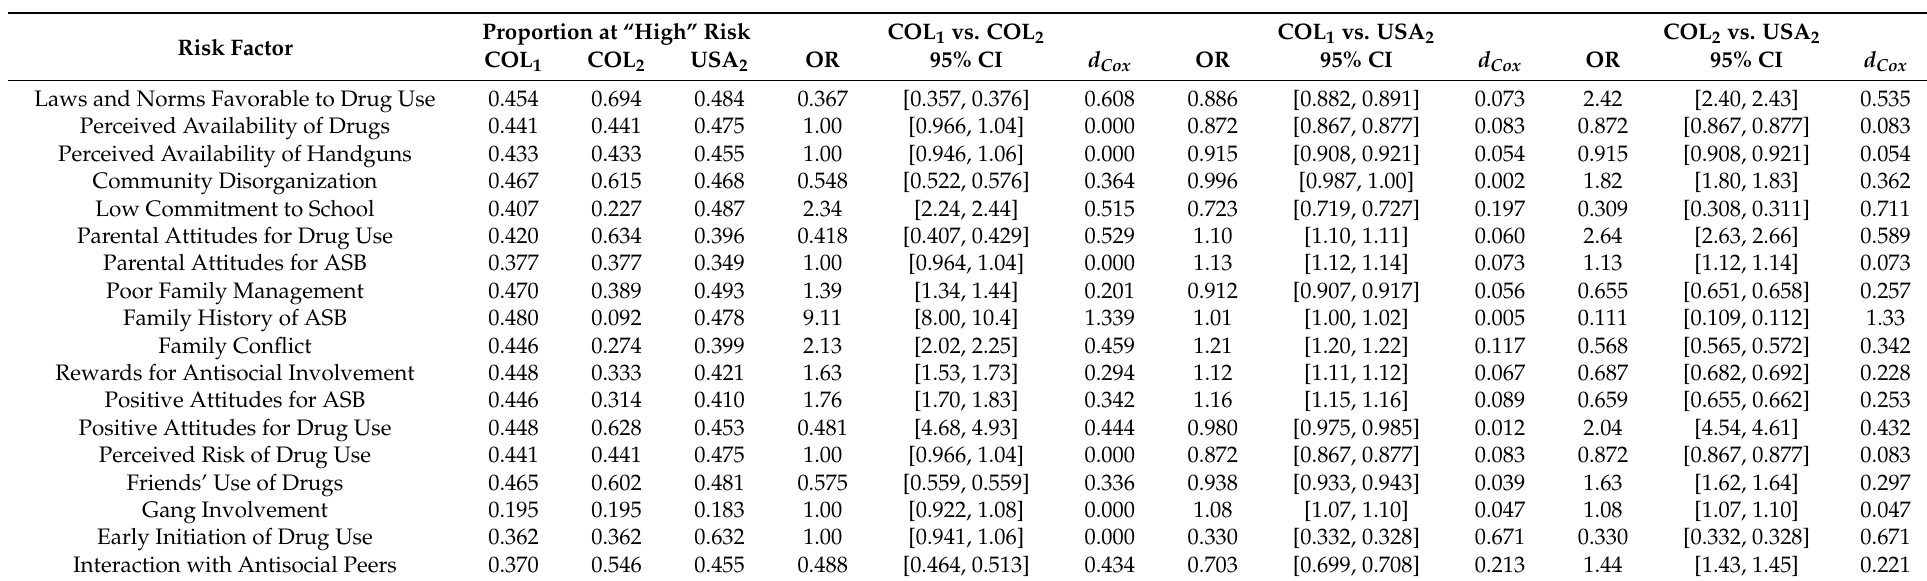
Table 3. Comparison of proportions of tenth-grade students at “high” risk, odds ratios, 95% confidence intervals, and effect sizes using Colombian and United States cut points. Risk